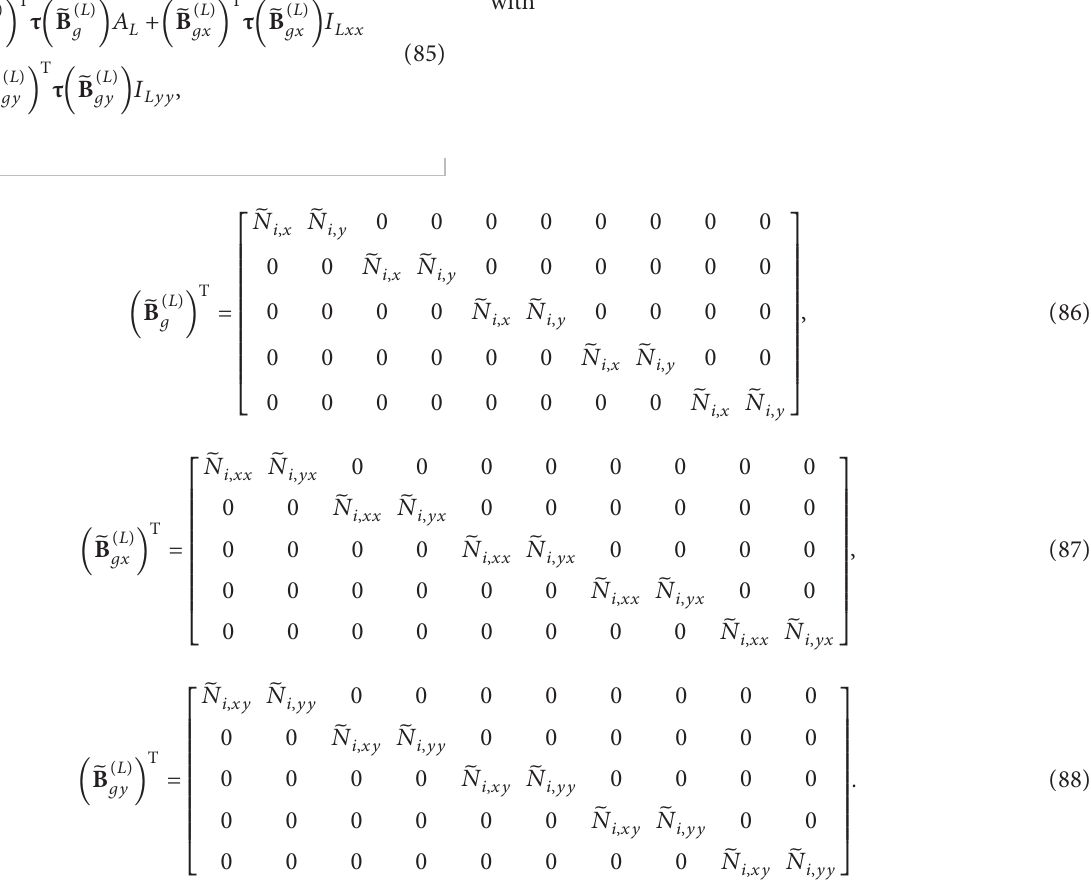
Figure 3. The geometric and material parameters are length L � 10 and thickness t � 2 . 0; E � 2 . 1 × 10 9 and v � 0 . 3. Due to symmetry, only a quarter of the plate is modeled to reduce the computation cost, and uniform meshes are employed. The center deflection w c is normalized as 􏽢 w � w c D / qL 4 , where D � Et 3 / ( 12 ( 1 − v 2 )) is the bending stiffness. In order to test